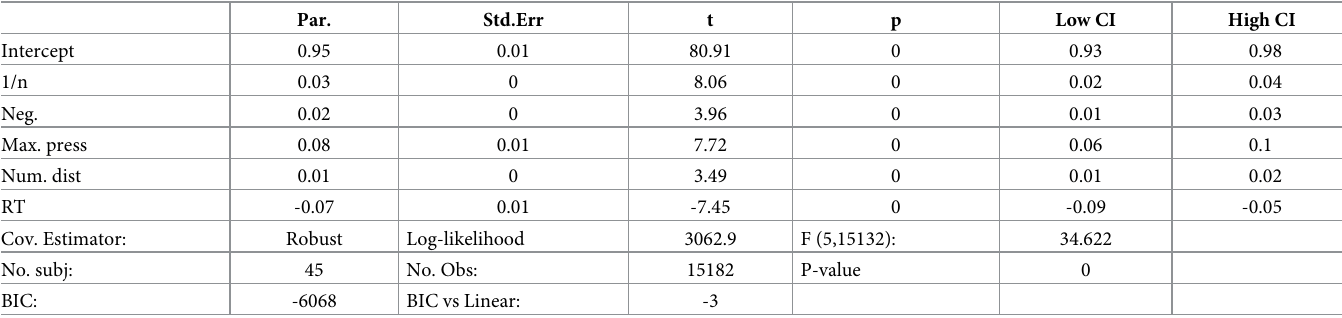
Table 3.1. Accuracy. Exp. 3. Fixed Effects Estimation.